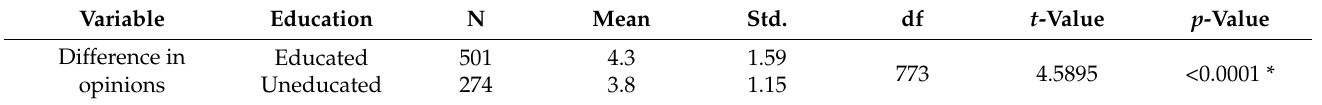
Table 5. Difference in the store factors influence for purchasing luxury brands (by education).